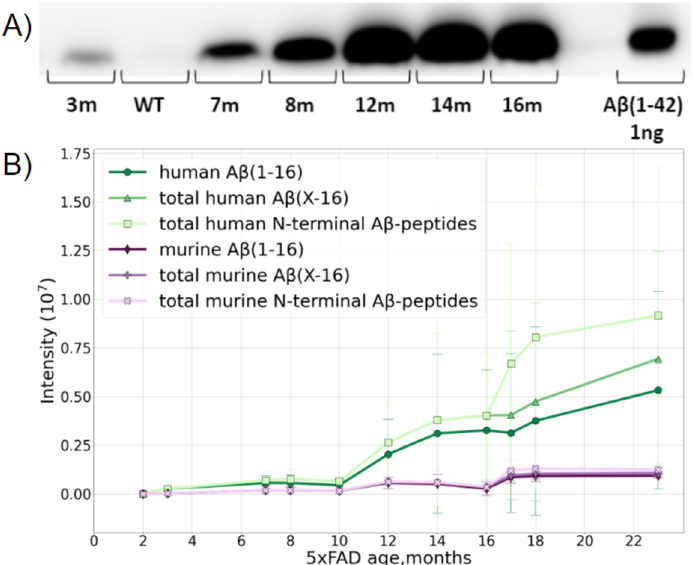
Figure 1. Dynamics of accumulation of A β in the brain of 5xFAD mice with age. ( A ) WB of A β extracted from 1 mg of brain tissue from mice of different ages. ( B ) Accumulation of human and murine A β with mouse age measured by LC-MS/MS. The accumulation and transformation of both native mouse A β (murine A β shown in purple) and transgenic human A β (shown in green) were monitored. A β (1–16) shows the changes in the intensity of a peptide starting at position 1 and ending at position 16, i.e., containing the first 16 N-terminal amino acids of A β . A β (X-16)—shows the sum of intensities of the variety of peptides starting at different positions on the N-terminus, i.e., 1, 2, 3, and so on, and all ending at position 16. The deviation of this value from the A β (1–16) curve demonstrates the input of the various truncated forms. Total N-terminal A β peptide curves show the sum of the intensities of all N-terminal peptides starting at various positions on the N-terminus, and ending at different positions on the C-end of the corresponding peptides. The deviation of these curves from the previous ones shows the accumulation and input of peptides carrying missed cleavages.